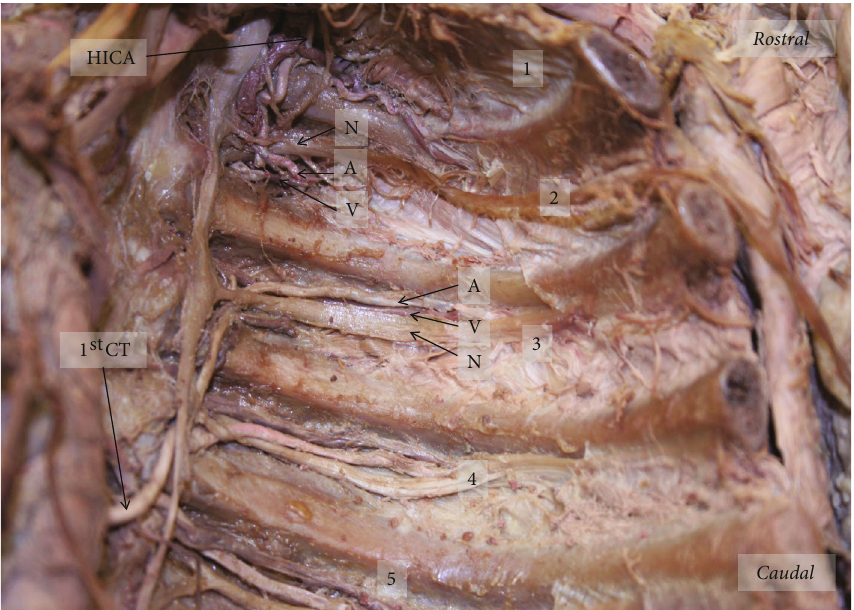
Figure 6: Left superior posterior thoracic wall showing neurovascular relationship in 2nd and 3rd ICS. The order of neurovascular bundle at the 2nd ICS (nerve, artery, vein) and 3rd ICS (artery, vein, nerve) from superior to inferior. Numbers 1-5: ICS number; HICA: highest intercostal artery; 1st CT: fi rst common trunk; N: nerve; V: vein; A: